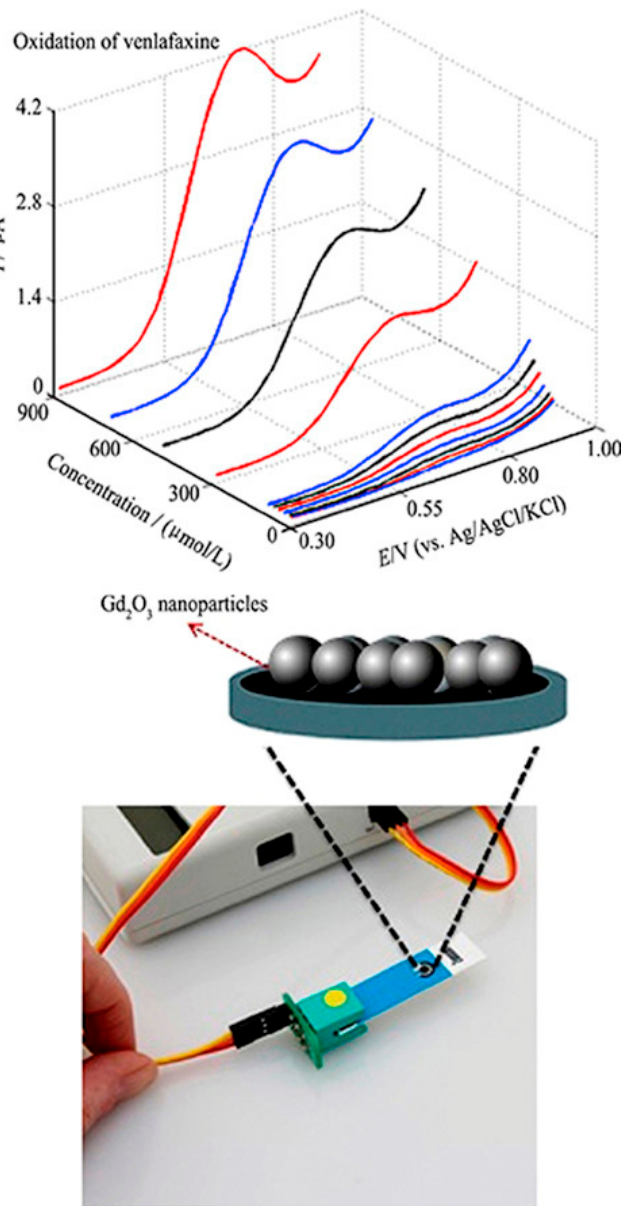
Figure 1. Electrochemical nanosensor for the determination of venlafaxine using Gd 2 O 3 /SPE. Reproduced with permission [3]. Copyright 2019, Elsevier.